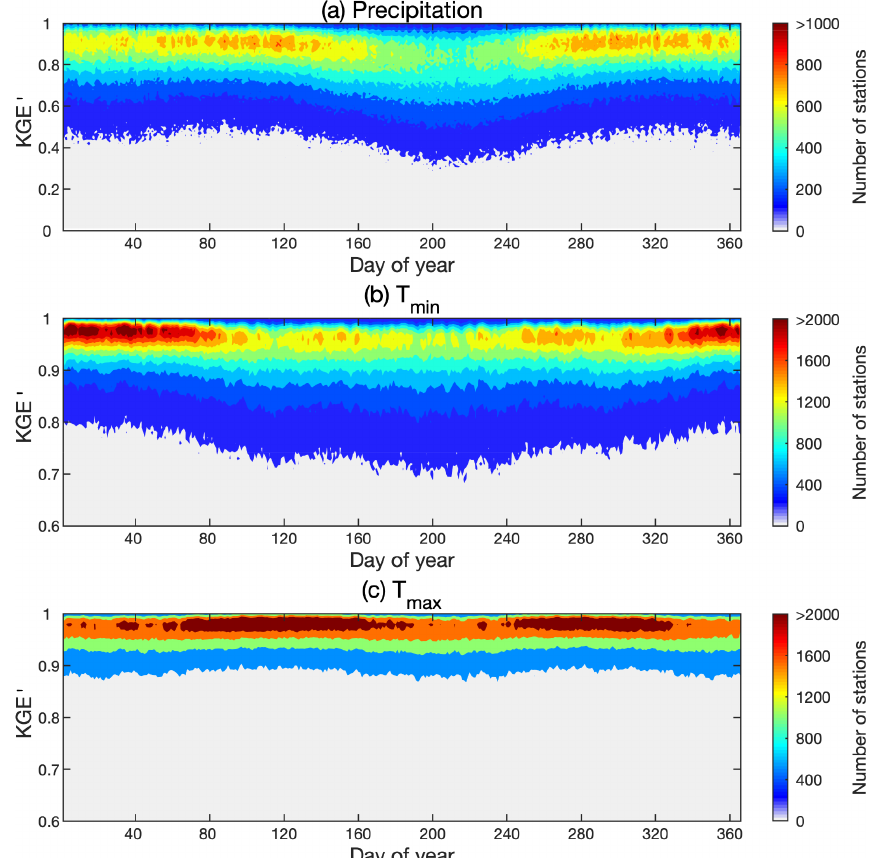
Figure 13. The distribution of KGE (cid:48) for each day of the year for (a) precipitation, (b) T min , and (c) T max . Corrected SCDNA estimates are